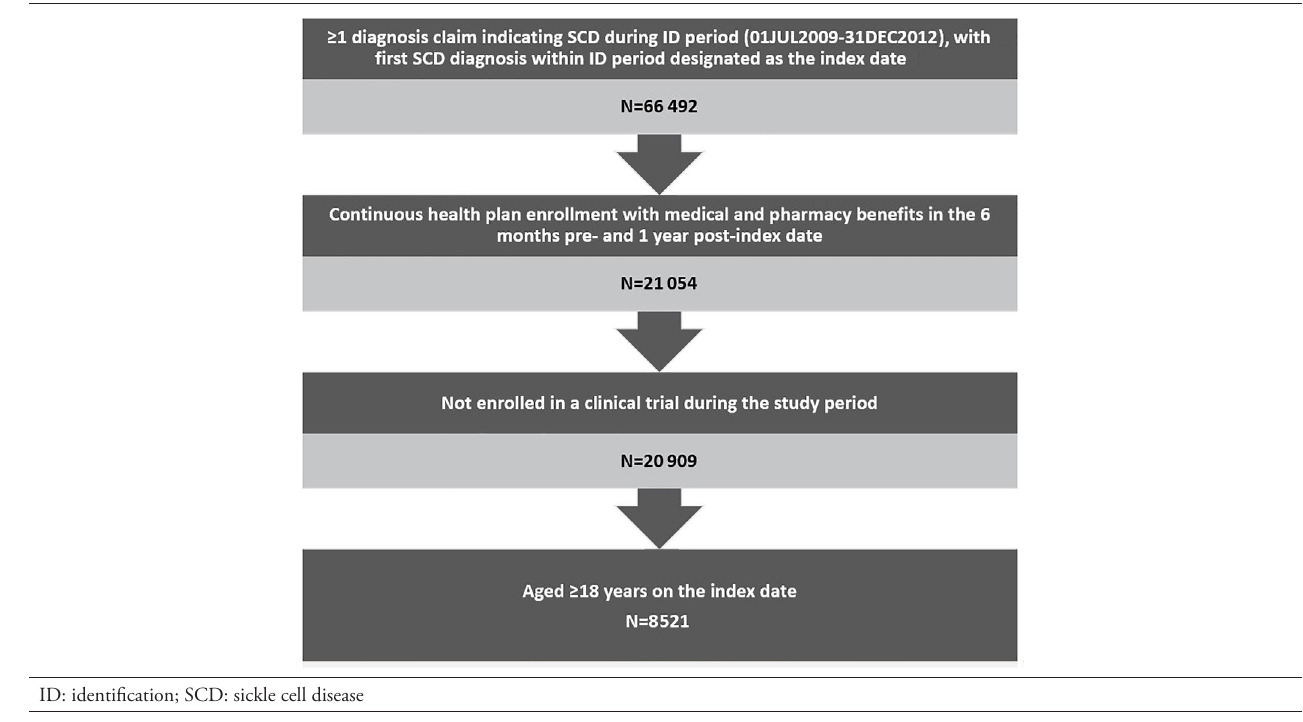
Figure 1. Patient Selection